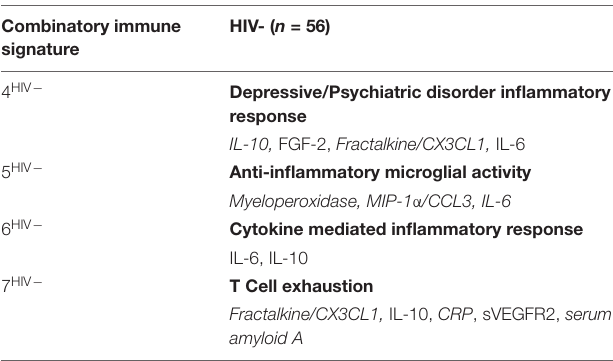
TABLE 4 | Strongest network of inflammatory markers contributing to Combinatory Immune Signatures that were specific to virally suppressed women with HIV (HIV +